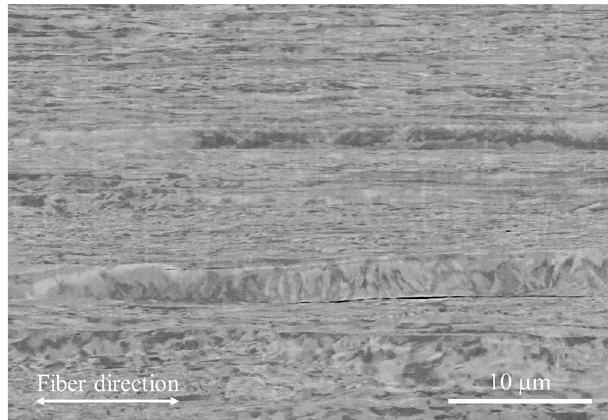
Figure 5. Microstructure of Fe–Co fiber with 100 μm diameters.